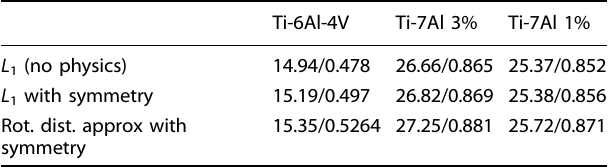
Table 5. PSNR/SSIM comparison for 4 × super-resolution scaling across different materials: Ti-6Al-4V, Ti-7Al 1%, and Ti-7Al 3% for HAN network: physics-based loss consistently outperforms bilinear, bicubic, nearest neighbor, and pure L 1 loss with no physics, and columns represent different titanium